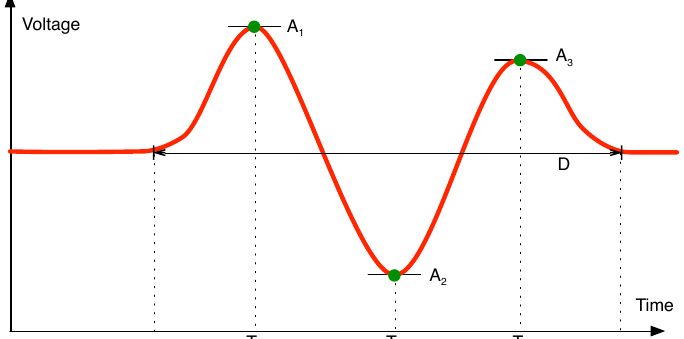
Figure 6. Feature extraction, amplitude (A and passage duration